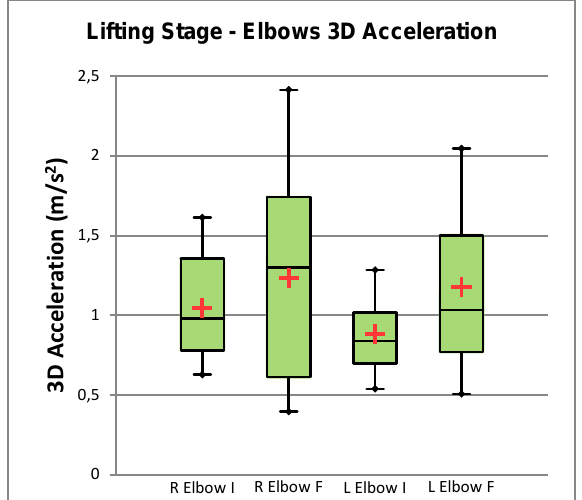
Figure 12 – Elbows Lifting 3D